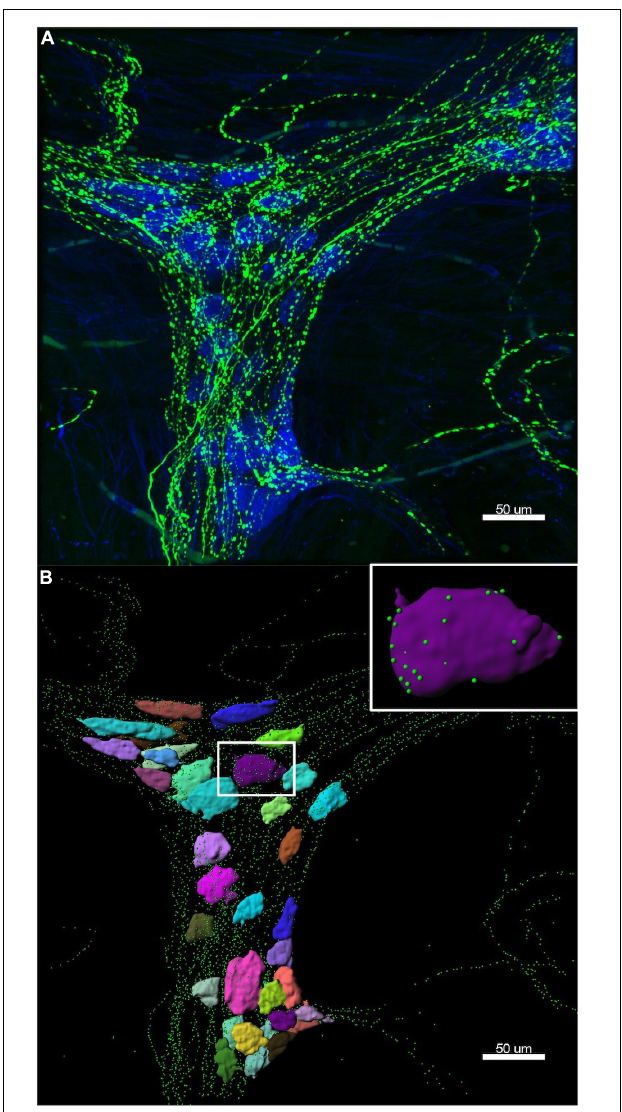
FIGURE 2 | Example of a 3D reconstruction. (A) Confocal image of the same ganglion shown in Figure 1 , with HuC/D cell bodies in blue and tyrosine hydroxylase (TH) varicosities in green. (B) The Imaris 3D reconstruction of HuC/D cell bodies is shown as multi-coloured surfaces to demonstrate individual cells, and TH varicosities are rendered as green spots. The colours assigned to the cells have no significance. Inset is a single HuC/D reconstructed cell body, with only the TH varicosities within 1 µ m of the cell surface shown. Imaris allows accurate measurement of distances between varicosities and cell body surfaces. Data extracted from these 3D reconstructions was used to calculate the density of TH varicosities close to each myenteric cell